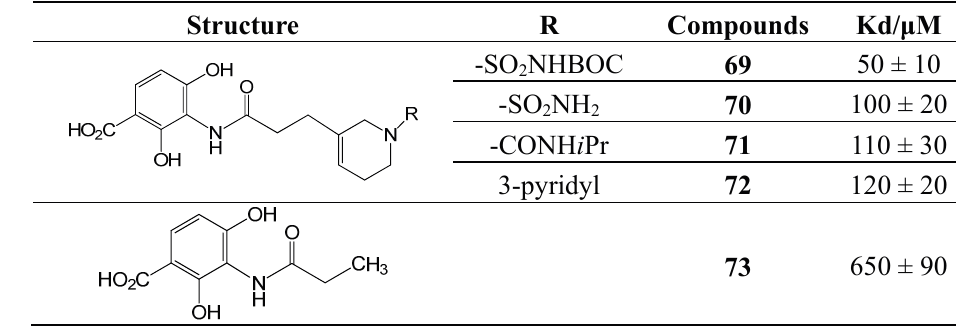
Table 2. Dissociation constants of compounds 69 , 70 , 71 , 72 and reference compound 73 for the C163Q mutant of